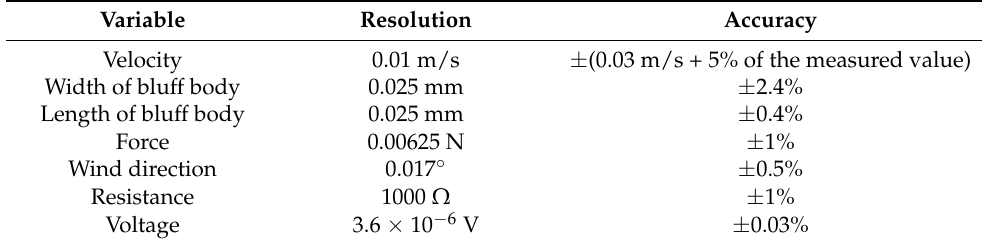
Table 1. The accuracy and resolution of measuring instruments and equipment.